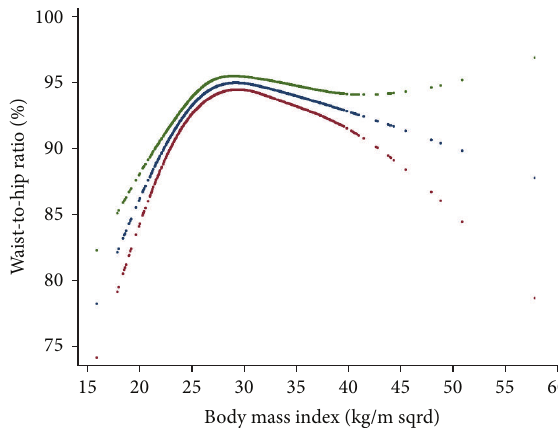
Figure 1: Inverse relationship of hip and waist circumference with body mass